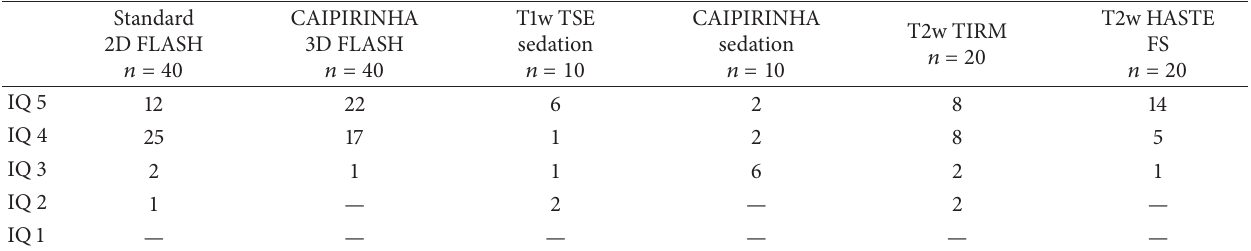
Table 2: Results of the consensus reading on overall image